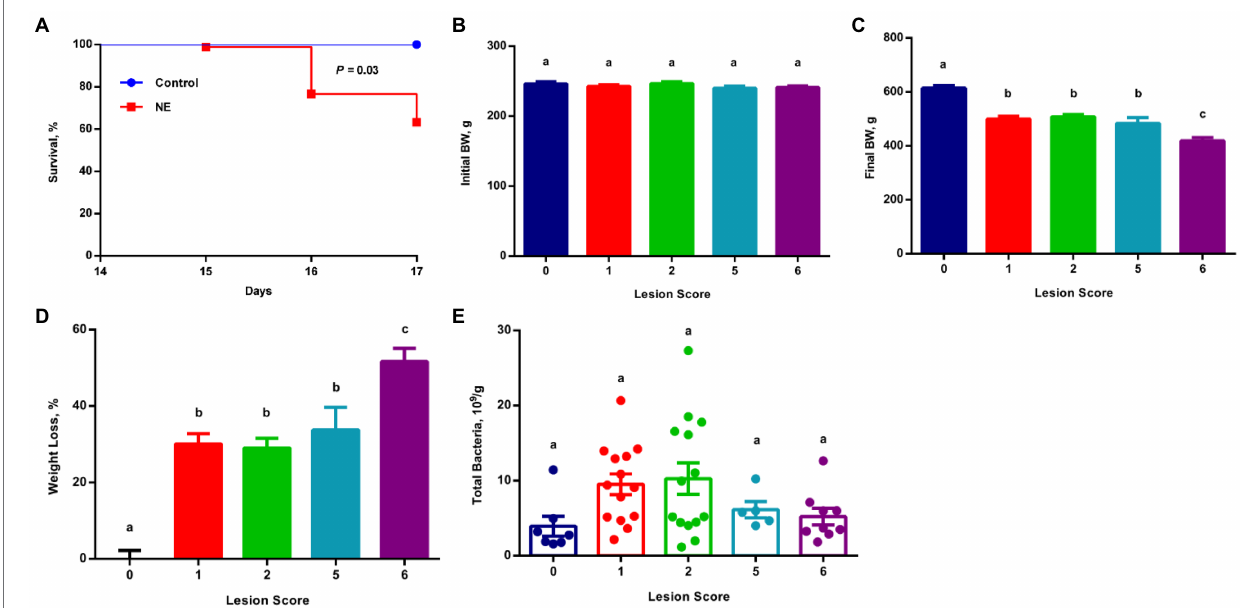
FIGURE 1 | Survival rate, growth performance, and total bacterial population among chickens with varying severities of necrotic enteritis (NE). A group of 90 male Cobb broilers were infected sequentially with Eimeria maxima on day 10 and Clostridium perfringens on day 14, while another 10 chickens were mock-infected as negative controls. Animals were separated into five groups according to their respective intestinal lesion scores measured on day 17. Animal survival was recorded daily between days 14 and 17 (A) and was compared between infected and mock-infected healthy animals using the log-rank test. Body weights of individual animals were recorded on day 10 (B) and day 17 (C) . Weight loss (%) of infected chickens during days 10–17 (D) was calculated relative to healthy controls. Total bacteria number in the ileal digesta (E) was also estimated using qPCR. All data were expressed as means ± SEM. Different superscripts denote significance ( p < 0.05) based on one-way ANOVA and Tukey’s post-hoc